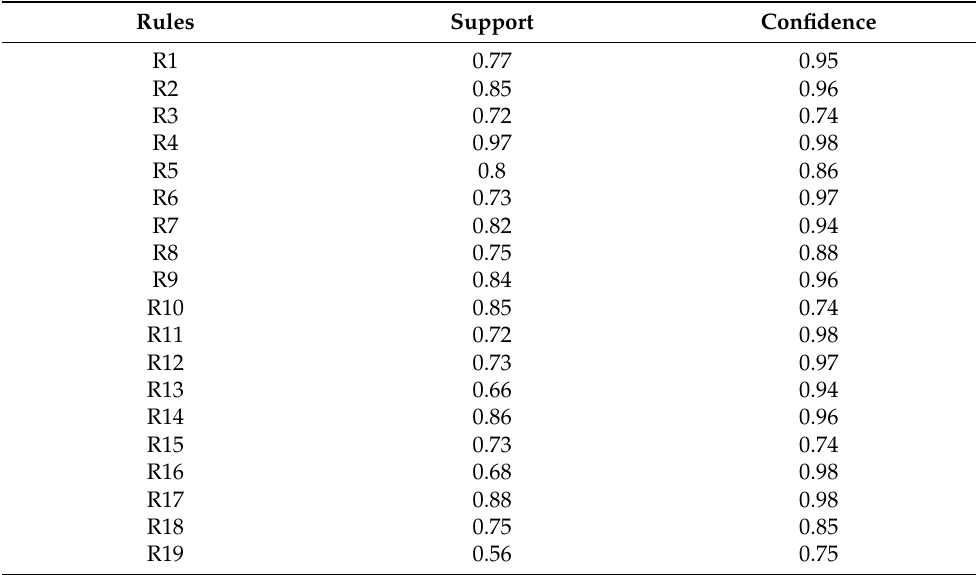
Table 3. Support values and confidence of the rules applied to the hotel set data